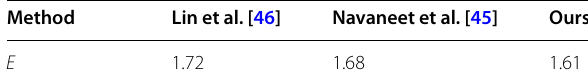
Table 3 Reconstruction error of the chair